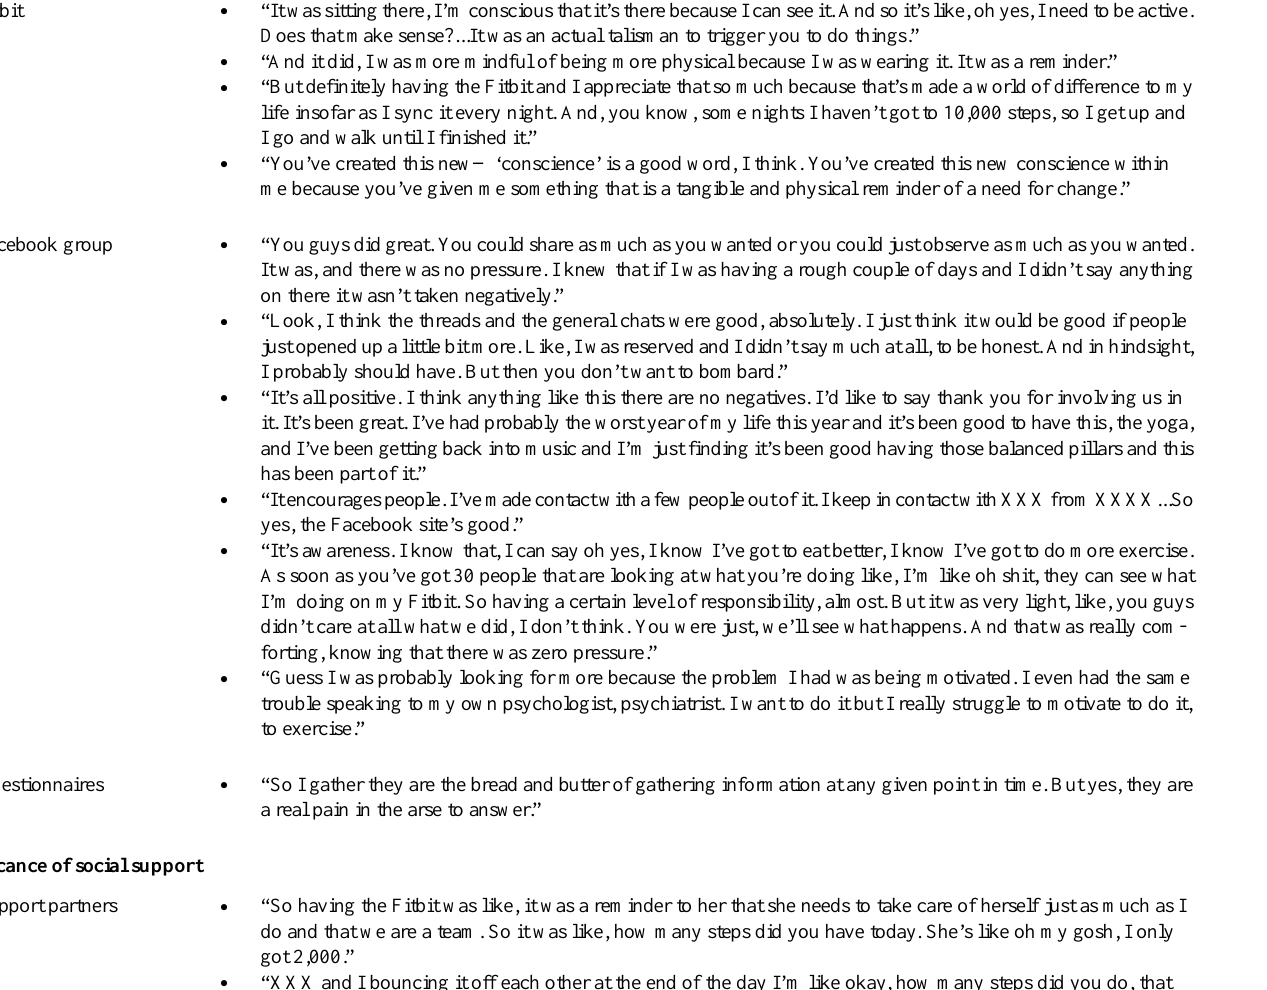
Examples of supporting quotationsThemes and